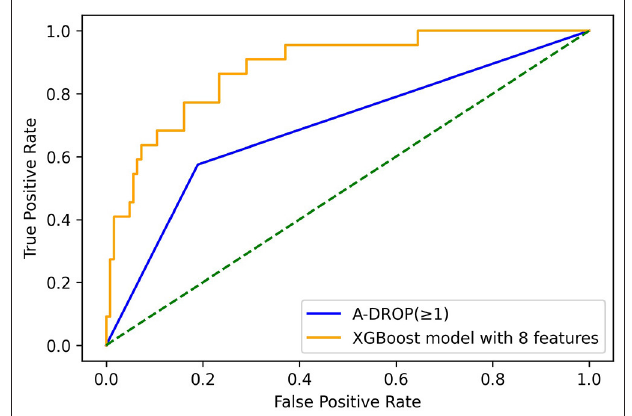
FIGURE 1 | C-statistic of XG Boost model with eight variables in external validation.